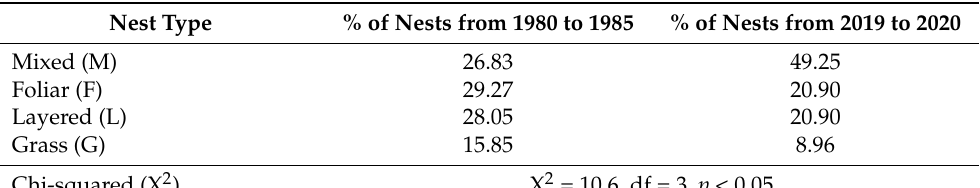
Table 2. Distribution of nest types in the periods 1980–1985 (n = 82) and 2019–2020 (n = 66). The chi-squared test shows a significant difference between selection of nest type in the two periods.